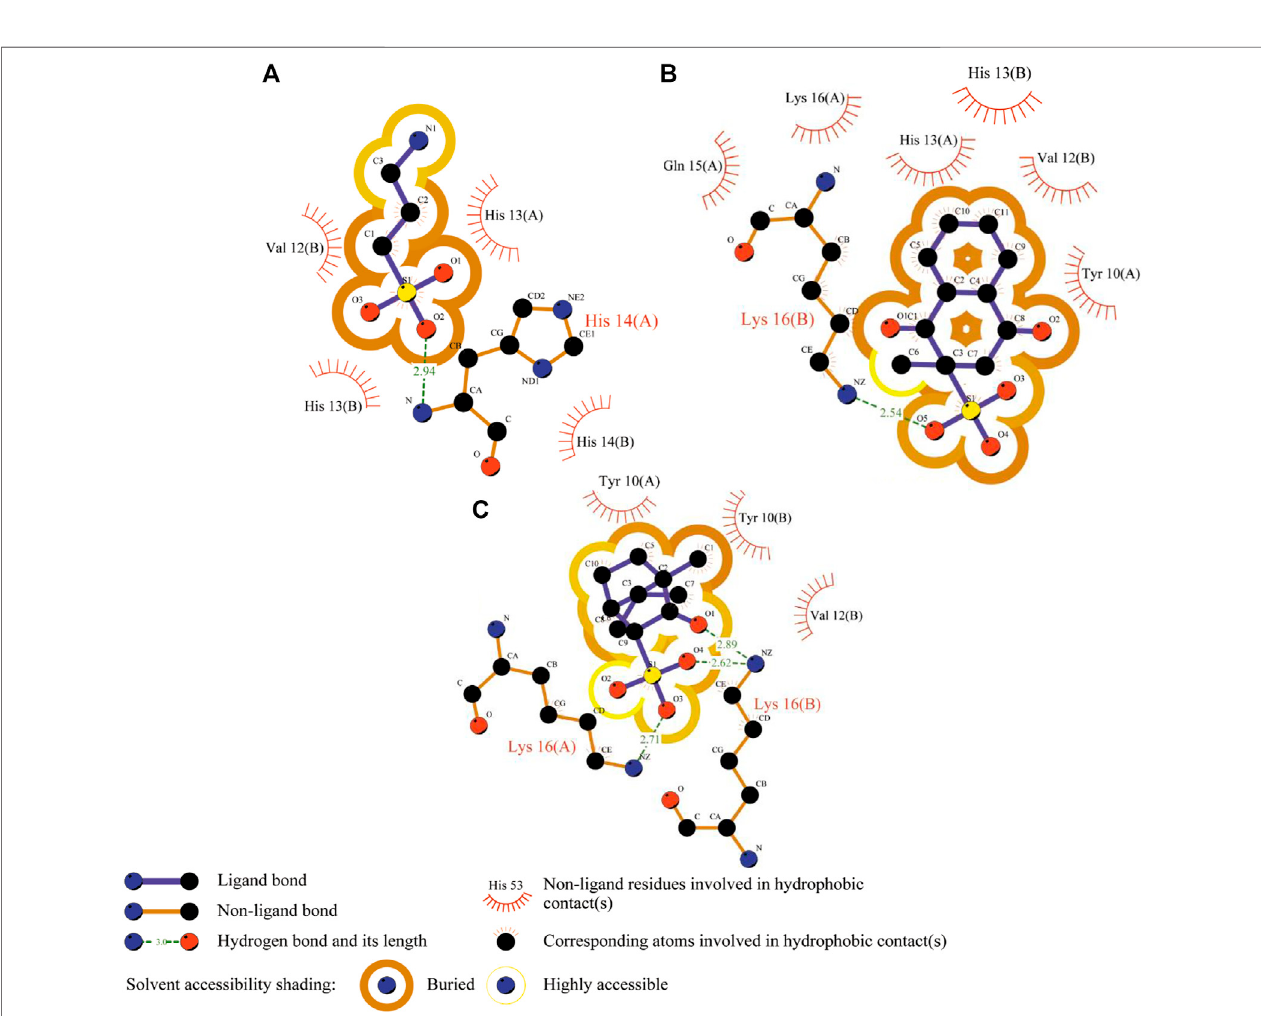
FIGURE 4 | 2D A β -ligand interaction diagrams predicted from the AutoDock runs for TRA (A) , menadione (B) , and camphotamide (C) bound to A β peptide. The chain information is shown in parentheses. All hydrogen atoms are removed to enhance clarity.